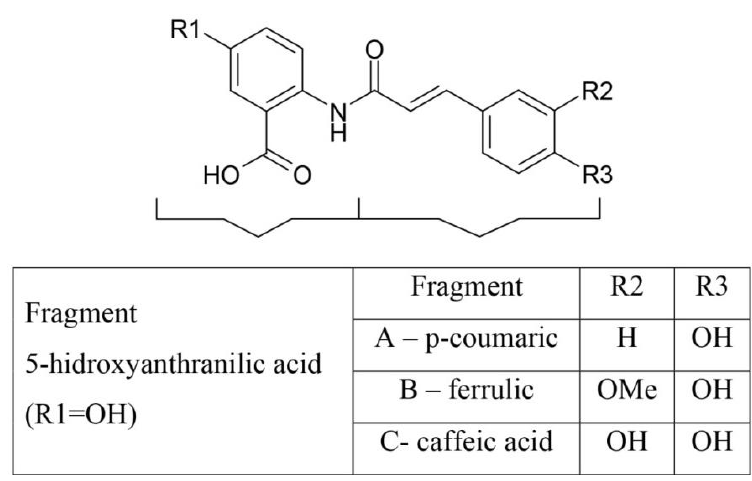
Fig. 1. General structure of avenanthramides AVA-A, AVA-B,